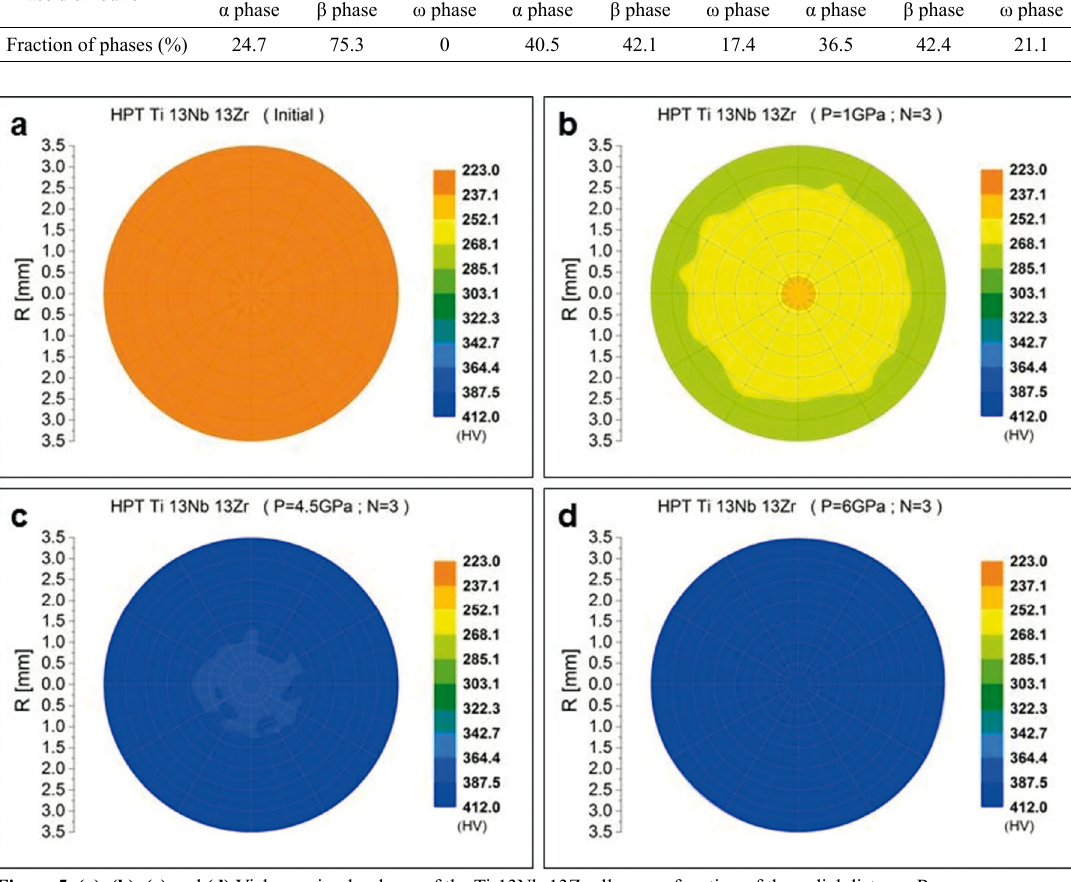
Figure 5. (a) , (b) , (c) and (d) Vickers microhardness of the Ti-13Nb-13Zr alloy as a function of the radial distance R.